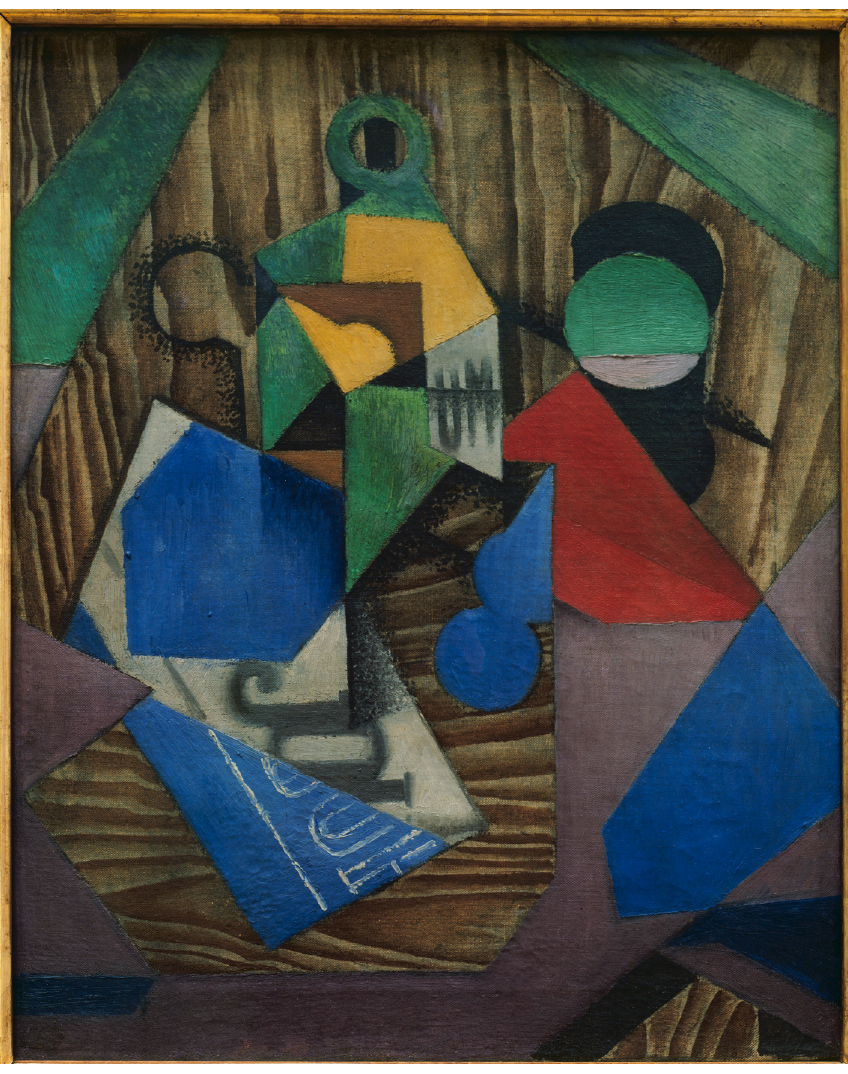
Fig. 2 Juan Gris (1887–1927), Bottle of Rhum and Newspaper , 1913–14, oil on canvas, 460 x 370 mm. London, Tate